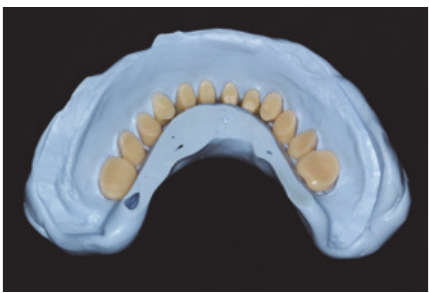
Figure 7: Silicone index registering the occlusal position of the denture teeth.